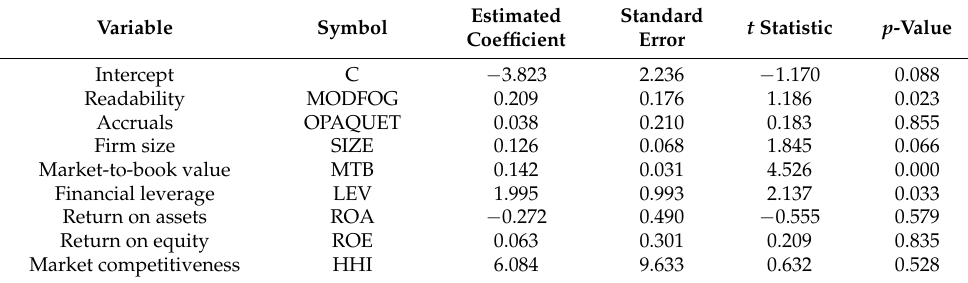
Table 10. Sensitivity analysis of the first hypothesis.